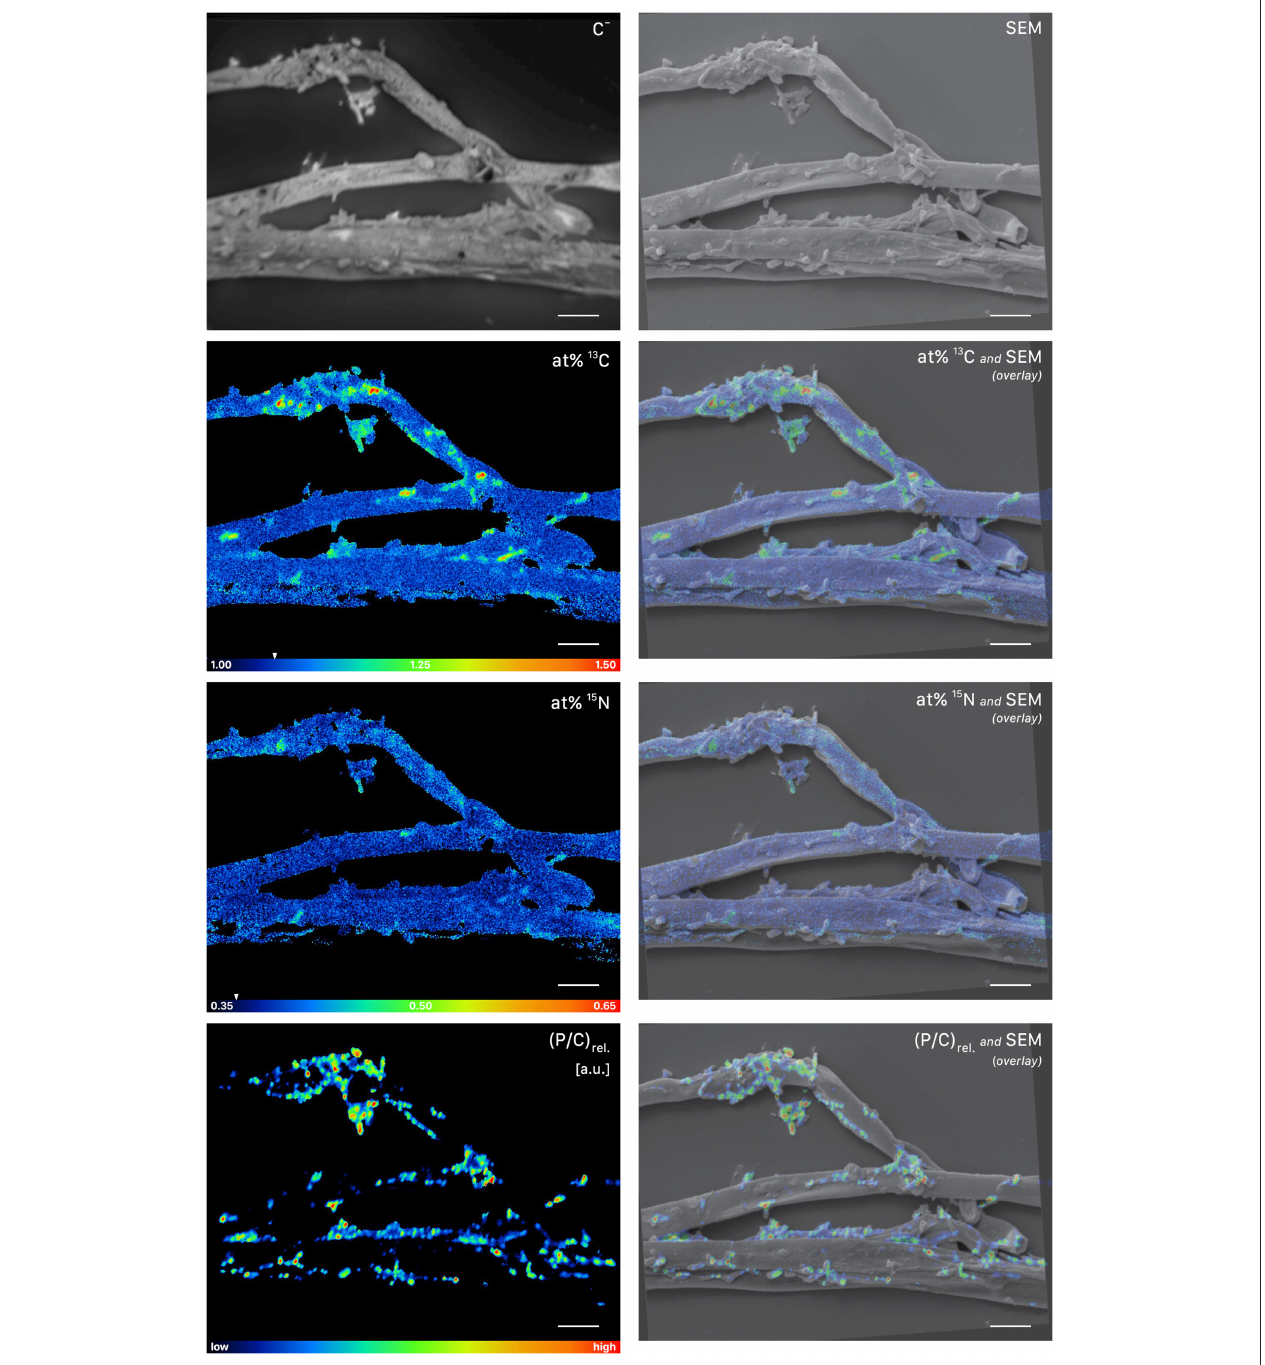
FIGURE 7 | NanoSIMS and SEM imaging of cells attached to root-distant fungal hyphae extracted from a litter compartment of a dual-labeled ( 13 C and 15 N) plant-box. SEM, scanning electron microscopy image (secondary electrons); C − , accumulated 12 C − and 13 C − secondary ion signal intensity distribution images, indicating the morphology of the sample during NanoSIMS analysis; at% 13 C, carbon isotope composition image, showing 13 C enrichment in microbial cells on the surface of the hyphae; at% 15 N, nitrogen isotope composition image. Isotopic label contents are displayed as atom%. The white arrows at the color-scales indicate the natural isotopic abundance values, determined on the unlabeled control (1.08 atom% 13 C and 0.37 atom% 15 N). The upper limit of the atom% 13 C scale is set to 1.50, maximum values range up to 1.56 atom%. Secondary ion signal intensity thresholds were set to 119, 51 and 58 counts/(sec*pixel) for 12 C 13 C − , 12 C 15 N − , and − normalized 31 P − secondary ion signal intensities, indicating the 31 P − respectively. (P/C) rel. , relative phosphor-to-carbon elemental ratio image as inferred from C presence of microbial cells on hyphal surfaces. Overlay images are composites of the SEM and NanoSIMS images. NanoSIMS images consist of accumulated z-stacks obtained from 24 consecutive scans. Scale bars, 5 µ